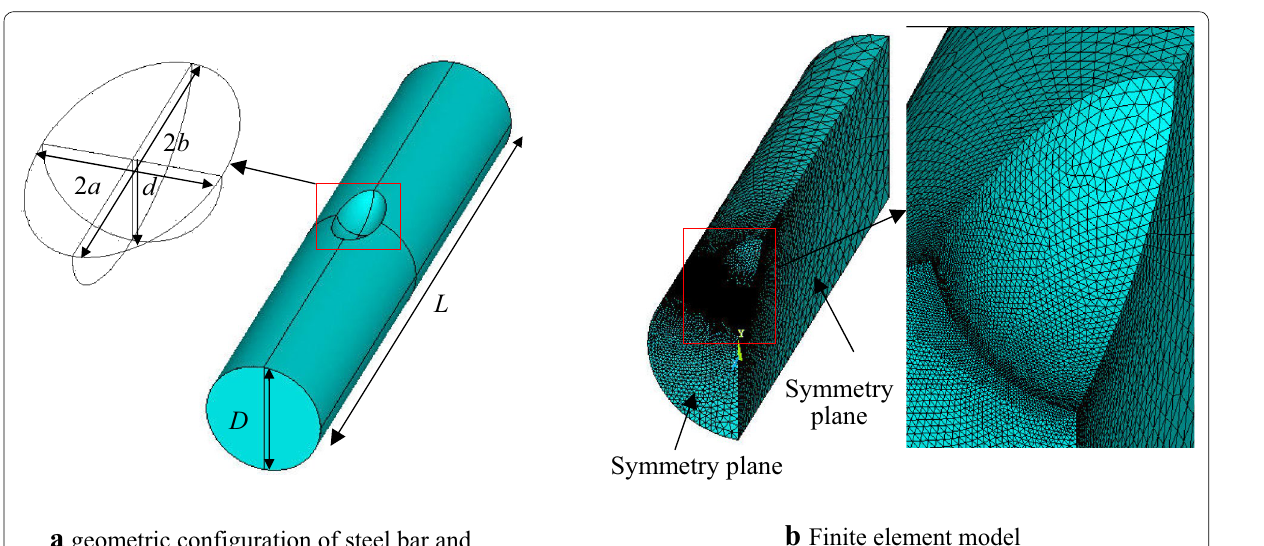
Fig. 4 Geometric configuration and finite element model.